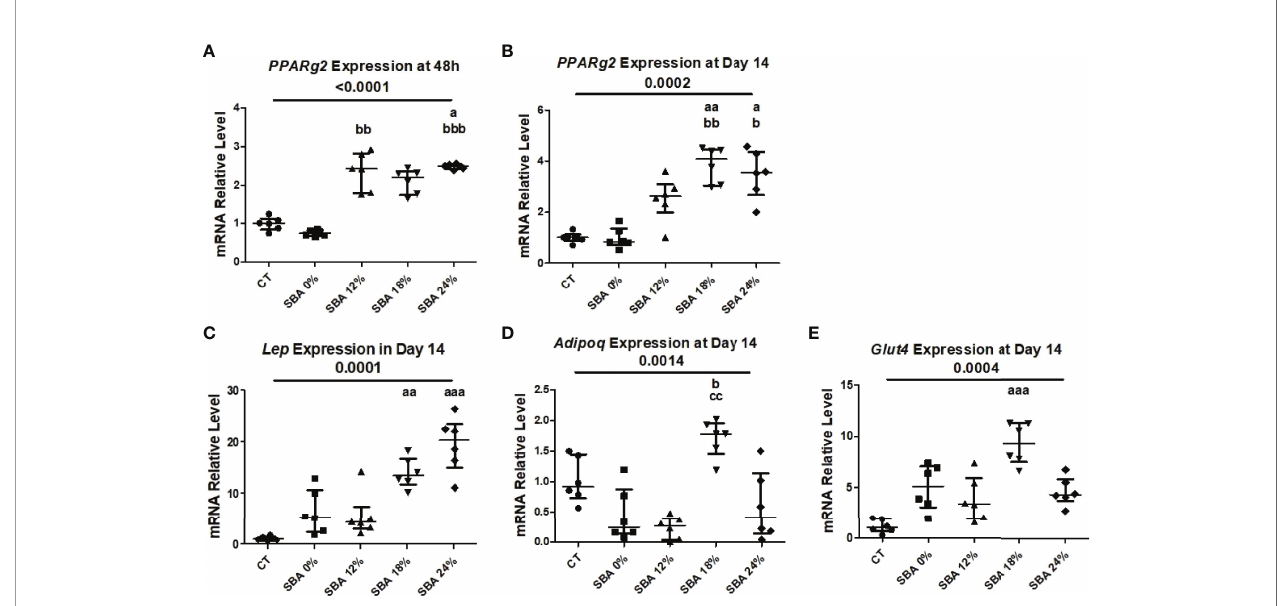
FIGURE 4 | 10-week SBA protocol induced an increase in adipogenesis. (A, B) Relative mRNA expression level of early adipogenic marker gene ( Pparg2 ) in CT and SBA groups (0%, 12%, 18%, 24%), cells were cultured for 48 hours in standard growth media and for 14 days were exposed to co-differentiation media, respectively; (C-E) Relative mRNA expression level of other adipogenic marker genes ( Lep, Adipoq , and Glut4 , respectively) in CT and SBA groups (0%, 12%, 18%, 24%) after exposure to co-differentiation media during 14 days. Data represent median and interquartile range; n=6. Statistical analysis was performed using Kruskal-Wallis One-Way ANOVA test and Dunn ’ s test; a - p < 0.05, aa - p < 0.005 and aaa - p < 0.0005 when compared to the CT group (b – when compared to the SBA 0% group; c – when compared to SBA 12% group). Peroxisome proliferator-activated receptor gamma 2 ( Pparg2 ), leptin ( Lep ), adiponectin ( Adipoq ), facilitated glucose transporter member 4 ( Glut4